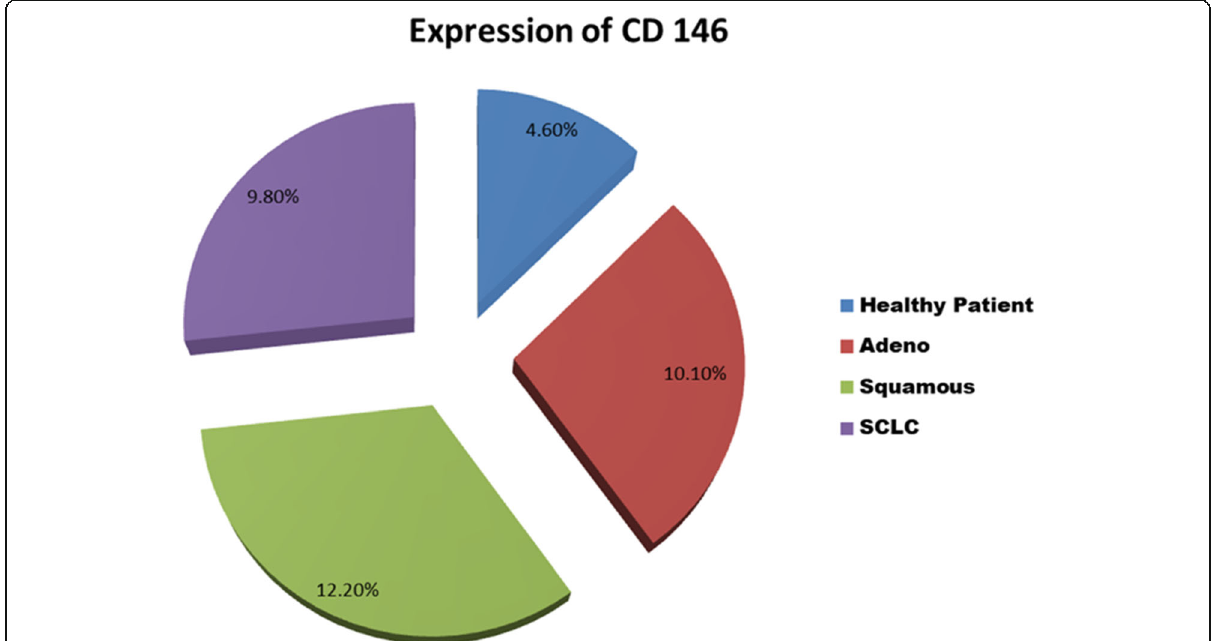
Fig. 2 CD146 expression on T cells in lung cancer patients. From the flow cytometry, the expression of the CD 146+ in the T cells includes 4.60 % in healthy patients, 10.10 %, 12.20 %, 9.80 % in adenocarcinoma, squamous and small cell lung cancer